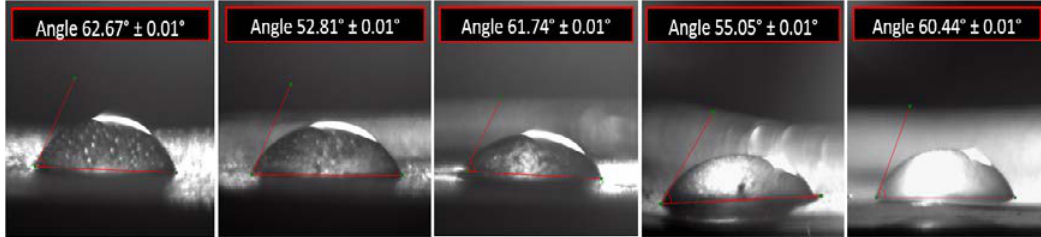
Figure 10. Droplet images and angles of wettability of coated samples on the solid film mode.